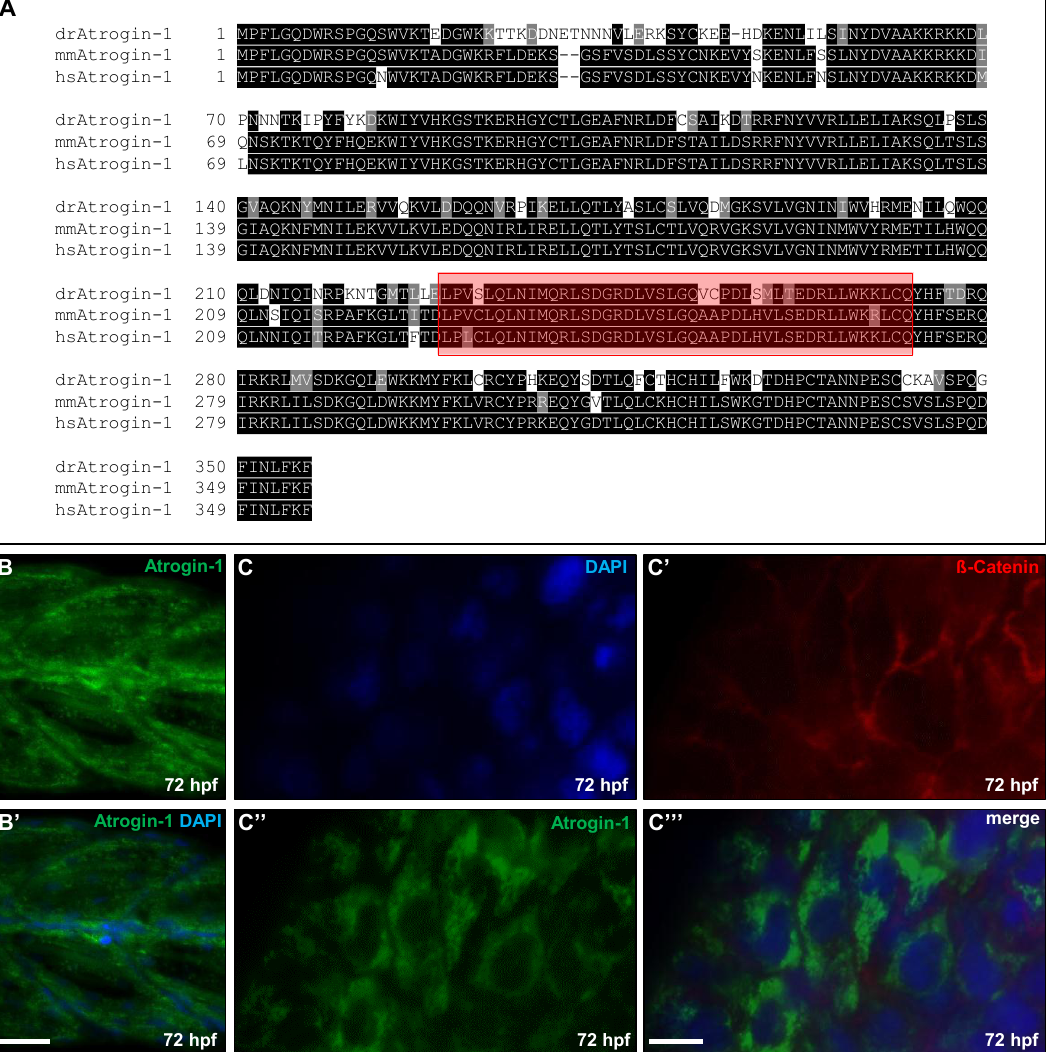
Figure 1. Atrogin-1 is conserved between humans, mice, and zebrafish and zebrafish Atrogin-1 is expressed in the embryonic skeletal muscle and heart. ( A ) Protein alignment of Danio rerio ( dr ), Mus musculus ( mm ) and Homo sapiens ( hs ) Atrogin-1, identical amino acids are shaded in black, similar amino acids in grey. Conserved F-box domain is depicted in red; ( B , B’ ) Immunofluorescent staining against Atrogin-1 on paraffin sections of zebrafish skeletal muscle at 72 hpf, nuclei are counterstained with DAPI, scale bar = 25 µm; ( C - C’’’ ) Immunofluorescent staining against Atrogin-1 (green) and ß-Catenin (red) on dissected zebrafish hearts at 72 hpf, nuclei are counterstained with DAPI, scale bar = 10 µm.